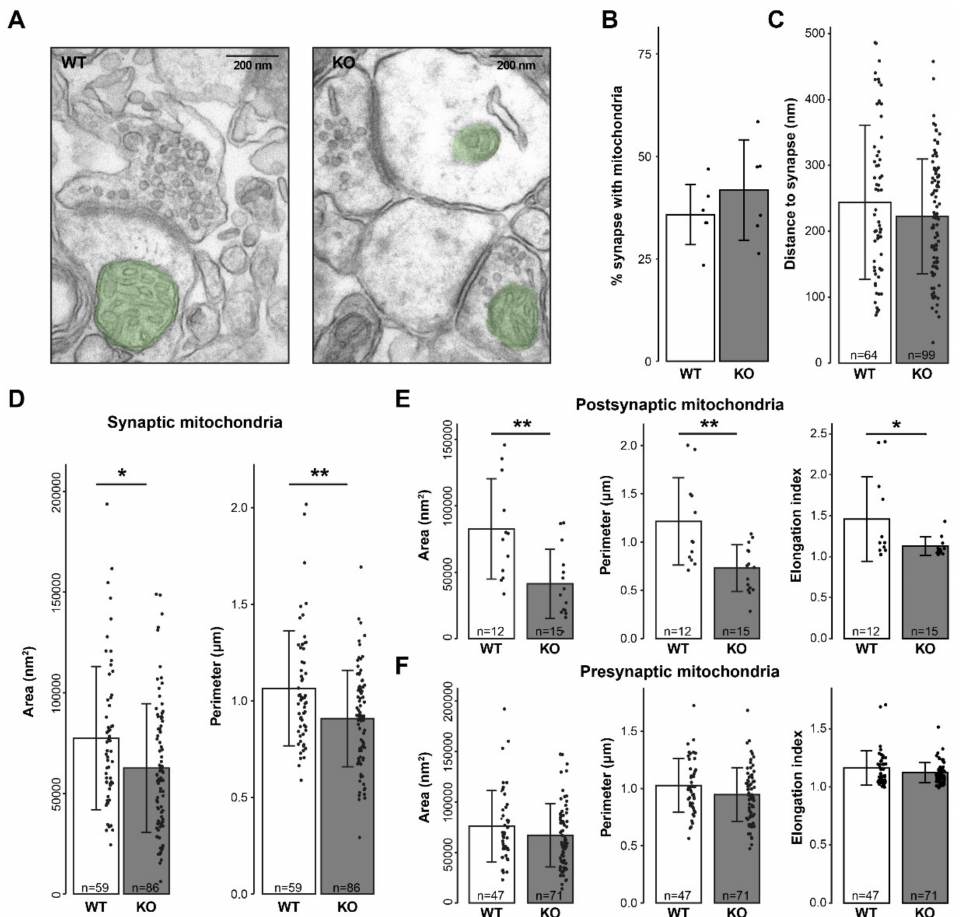
Figure 2. Electron microscopy analysis of mGluR5 KO synaptic mitochondria. ( A ) Representative images of typical asymmetric glutamatergic synapses from WT and mGluR5 KO hippocampus (N = 6). Synaptic mitochondria are highlighted in green. ( B ) Percentage of synapses containing mitochondria in either the pre- or post-synaptic compartment (N = 6, n = 209 for WT; N = 6, n = 247 for KO). No significant difference was found between WT and KO ( t -test, p = 0.64). ( C ) Linear distance from the presynaptic and postsynaptic mitochondria to the active zone and postsynaptic density, respectively. No significant difference was found between WT and KO (nested p = 0.29). ( D ) Area and perimeter of mitochondria located in both the pre- and post-synaptic compartment were significantly reduced in KO mice (nested p = 0.028 and 0.003, respectively). ( E ) Area, perimeter and elongation index of mitochondria located in the post-synaptic compartment were significantly reduced in KO mice (nested p = 0.002, 0.001 and 0.019, respectively). ( F ) No significant differences were found between WT and KO in the area, perimeter and elongation index of mitochondria located in the presynaptic compartment (nested p = 0.20, 0.09 and 0.11, respectively). * p < 0.05, ** p < 0.01. All bar graphs, means ±